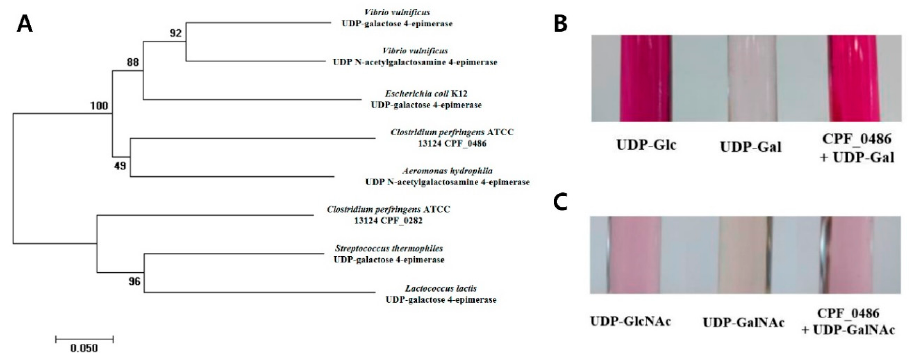
Figure 4. CPF_0486 function was characterized using a colorimetric assay. ( A ) Phylogenetic tree showing the amino acid sequence relatedness of C. perfringens CPF_0486 with UDP-glucose 4- epimerase and UDP- N -acetylglucosamine 4-epimerase of other species using the MEGA7 software. ( B ) Glucose oxidation (GO) assay. UDP-Glc, UDP-glucose (2 mM); UDP-Gal, UDP-galactose (2 mM); CPF_0486 +UDP-Gal, CPF_0486 with UDP-galactose (2 mM). (C) Morgan–Elson reaction assay. UDP-GlcNAc, UDP- N -acetylglucosamine (0.2 mM); UDP-GalNAc, UDP- N -acetylgalactosamine (0.2 mM);